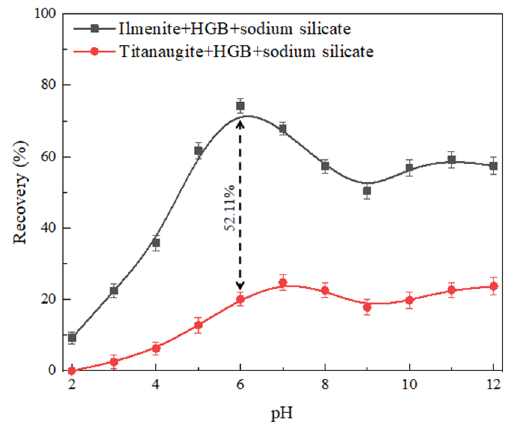
Figure 7. Effect of pH on flotation recovery of fine ilmenite and fine titanaugite mixed with HGB after treated with sodium oleate and sodium silicate (the mineral size distributions of 0–19 µm, 4.0 × 10 −4 mol·L –1 sodium oleate, 10 mg·L –1 sodium silicate, HGB dosage = 0.02 g).